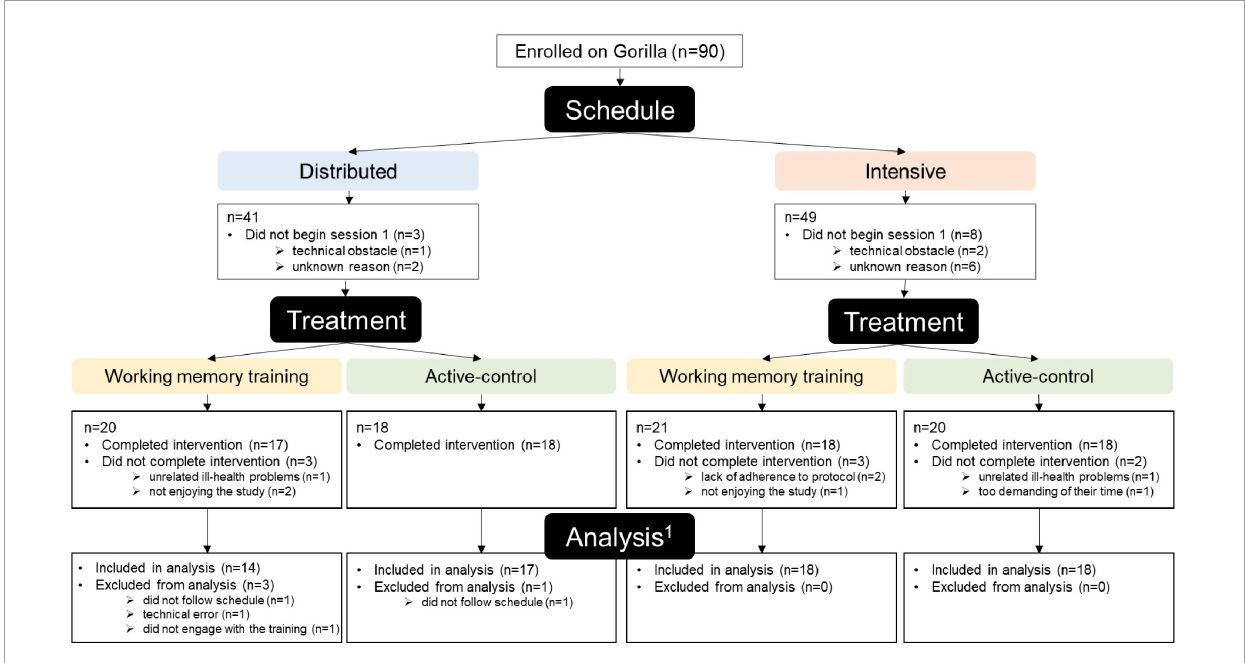
FIGURE1 Flow diagram of progress through the phases of the study ( 1 The number of participants eligible for inclusion in each analysis varies slightly, see section “2.4. Participant adherence and exclusions”).